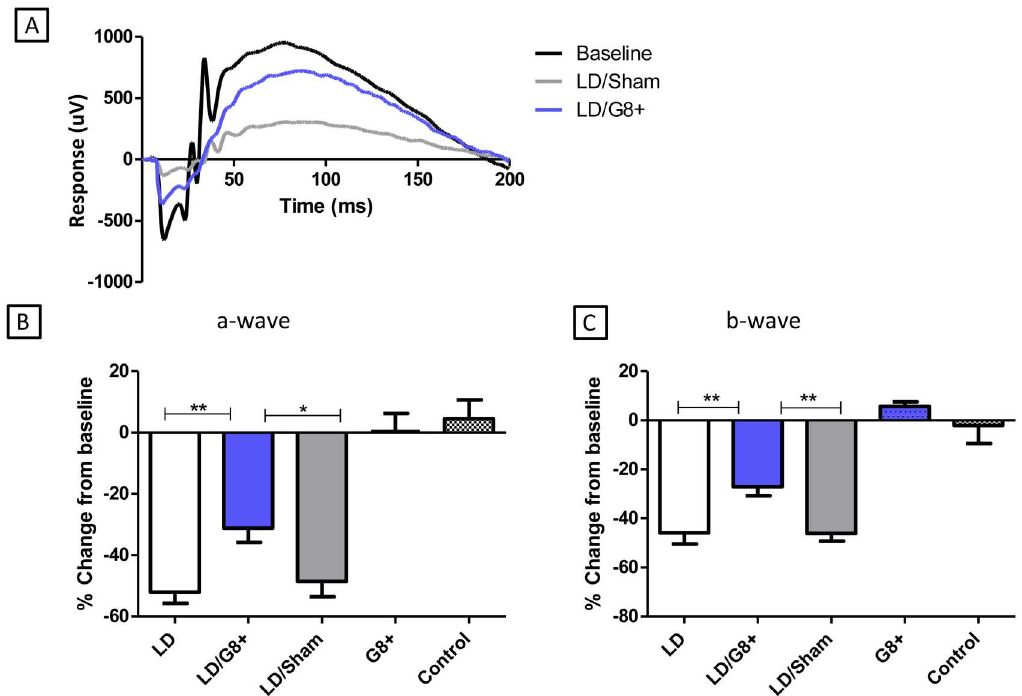
Fig 4. Intravitreal injection of Myo/Nog cells partially preserved visual function after light damage. Visual function was assessedusing the ERG 7 days after light damage. The a-wave and b-wave amplitudesin response to bright flash were normalised to baseline(before light damage)bright flash responsesand averagedfor each treatment group. Controlanimalssuffered no injectionand no light damage.G8+ animals suffered no light damagebut were injectedwith purifiedG8+ cells and assessed 7 days after injection. LD stands for Light damage. (A) Representative ERG traces from eyes with LD alone, LD eyes injected with PBS (LD/sham) and LD eyes injectedwith G8+ (LD/G8+). (B) Mean changein a-wave amplitudes for retinas from the 5 experimental groups, from before treatment. Error bars show SEMs. Controlrats that did not receive light damageshowedno significantchangein the a-wave betweenthe two ERG measurements (n = 4). Control rats that did not receivelight damage,but were injectedwith G8+ cells also showed no significantchange in the a-wave betweenthe two ERG measurements (n = 3). Visual function, as measuredby the a-wave, was significantly improvedfollowinglight damage with injectionof G8+ cells (n = 18) comparedto LD alone (n = 18) and LD/sham (n = 18) (LD/G8+: vs. LD ** p < 0.01, vs. LD/Sham * p < 0.05).